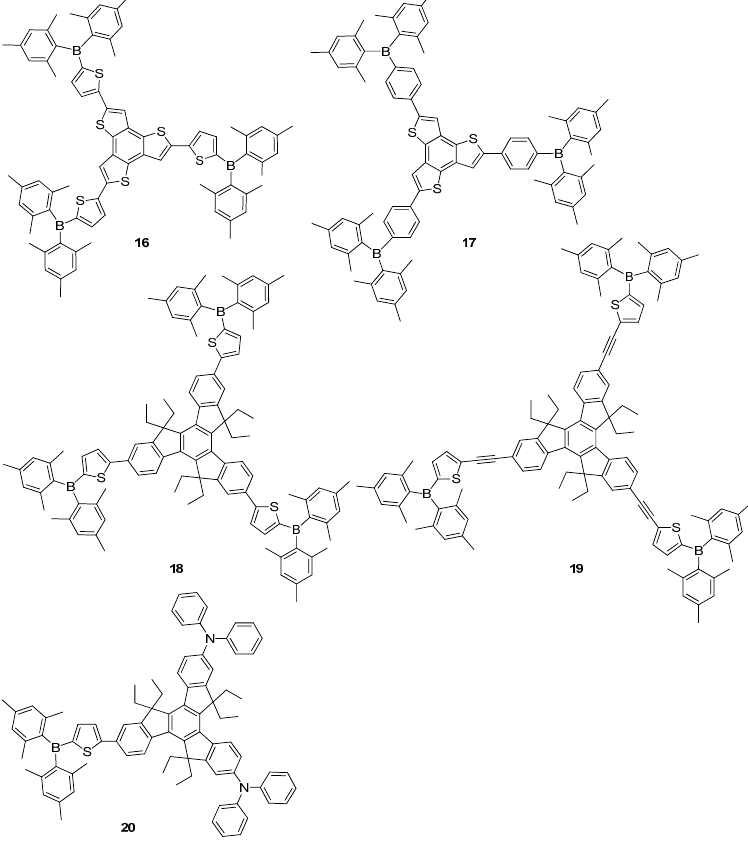
Figure 6. Triarylborane-based octupolar π -conjugated materials 16 – 20 .